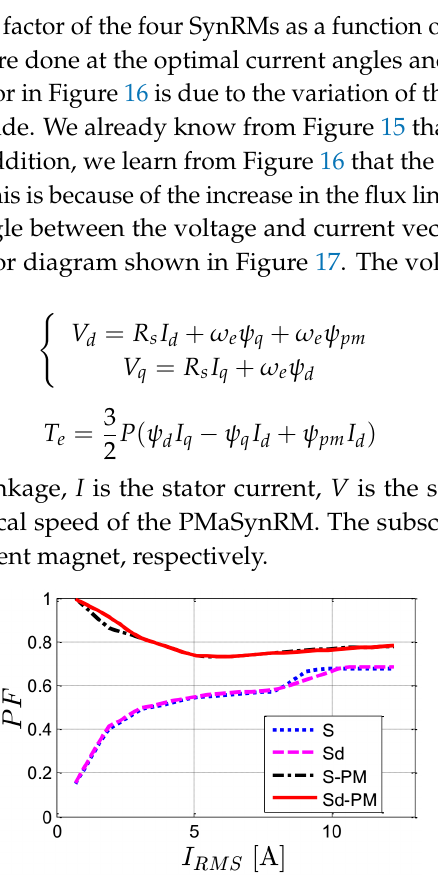
Figure 16. SynRM power factor ( PF ) as a function of stator current ( RMS ) at optimal current angles and rated speed.